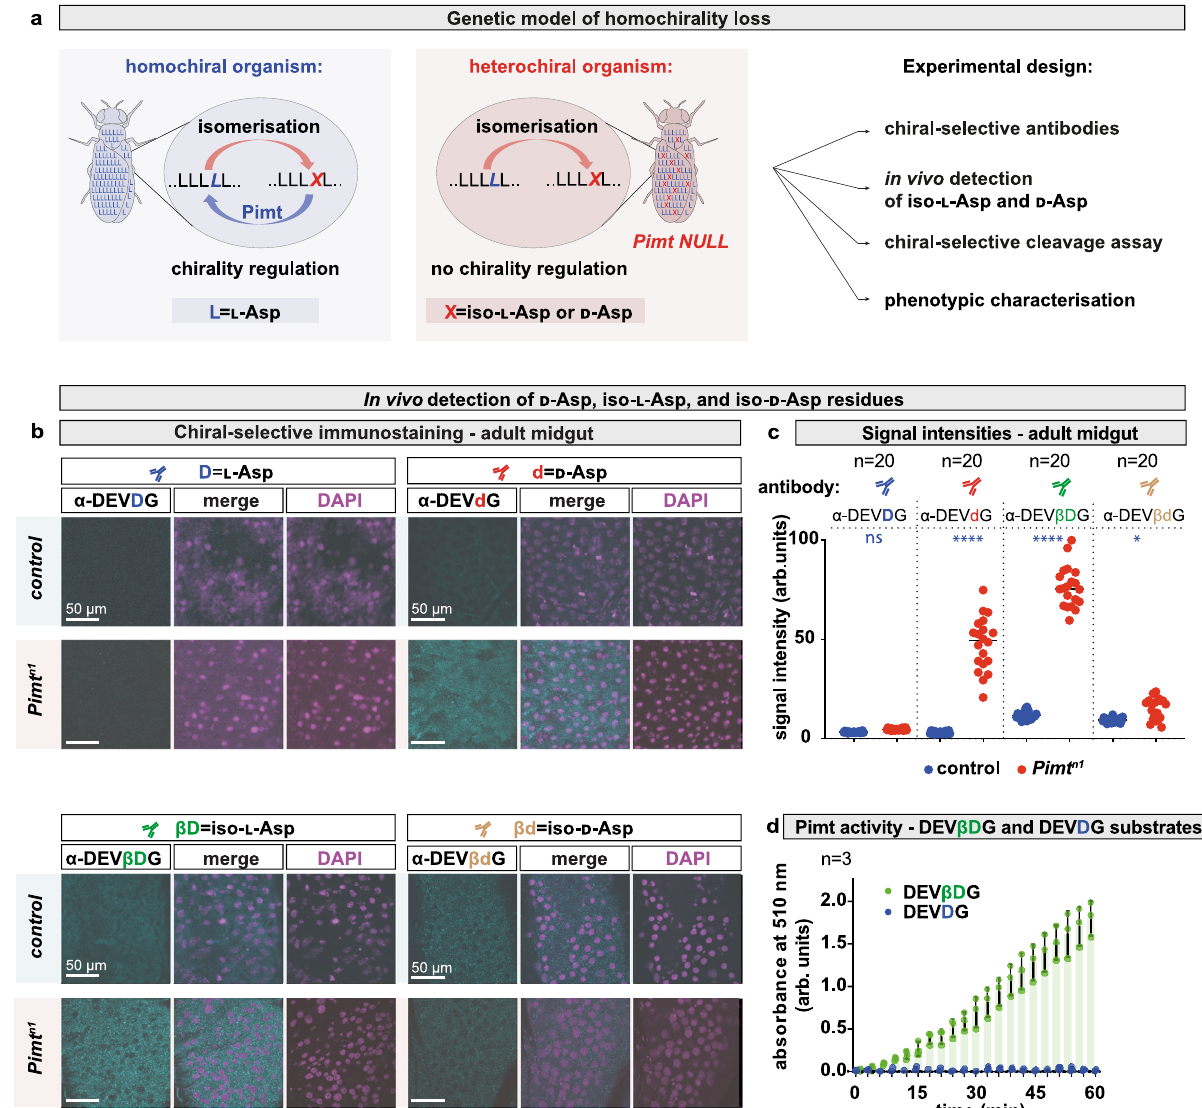
Fig. 1 | Development of chiral-selective antibodies to detect heterochirality in vivo. a Schematic representation of Pimt enzymatic activity and experimental design to assess the physiological effect of loss of protein homochirality. Animals lackingPimtactivityaccumulateheterochiralproteinsduetothelackofcorrection of post-translational chiral errors. For this and all subsequent fi gures, light blue shading highlights homochiral and light red shading highlights heterochiral ani- mals. b Detection of hetero-neoepitopes in control and Pimt n1 chiral-de fi cient 20 days-old animals. The anti-DEV d G, anti-DEV β D G, and anti-DEV β d G antibodies (where d correspondsto D -aspartate, β D toiso- L -aspartateand β d toiso- D -aspartate) weredesignedtorecognisehetero-neoepitopesintheproteomecontaining D -, β - L -, and β - D -AA. As a control, anti-DEV D G was raised against a homochiral peptide. Dissectedadultfemalegutswerestainedwithanti-DEV D G(blue),anti-DEV d G(red), anti-DEV β D G (green), or anti-DEV β d G (yellow) antibodies. Guts of control animals did not show any immunoreactivity, while Pimt n1 showed positive staining for the